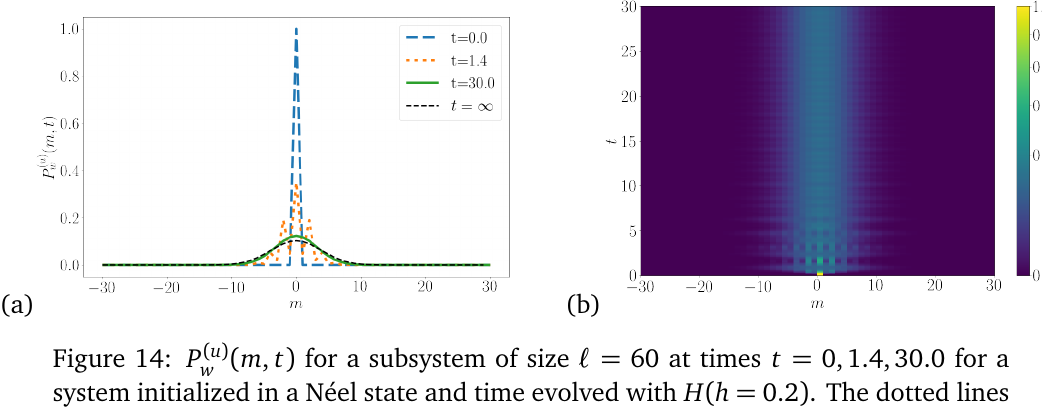
( m , t ) for a subsystem of size (cid:96) = 60 at times t = 0,1.4,30.0 for a Figure 14: P ( u ) w system initialized in a Néel state and time evolved with H ( h = 0.2 ) . The dotted lines are the asymptotic probability distributions given in